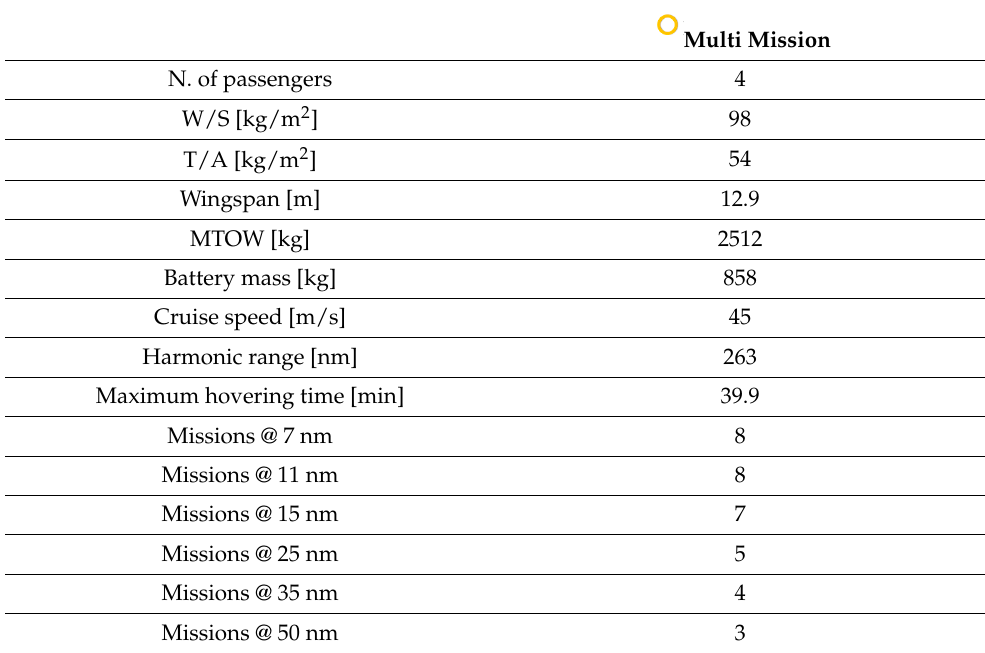
Figure 21. Details of the TiltOne configuration for multi mission case: ( a ) top view; ( b ) mass breakdown. Table 15. Main performance data of the TiltOne configuration for multi mission case.